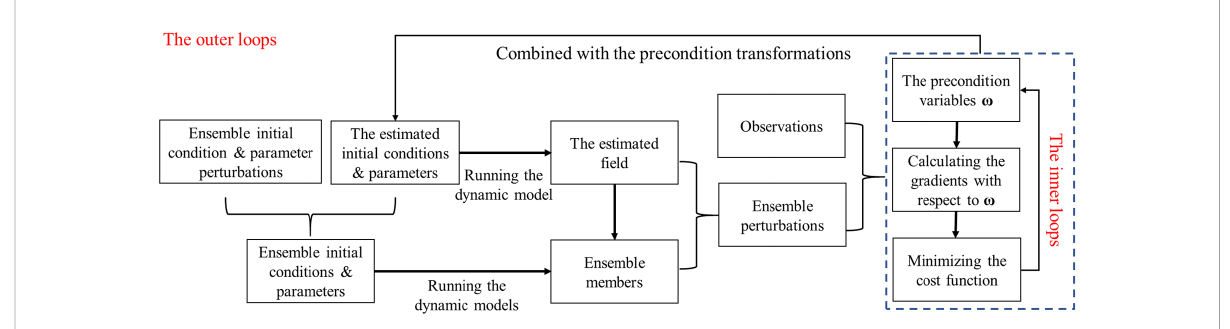
FIGURE 1 The fl owchart of the operational improved analytical four-dimensional ensemble variational